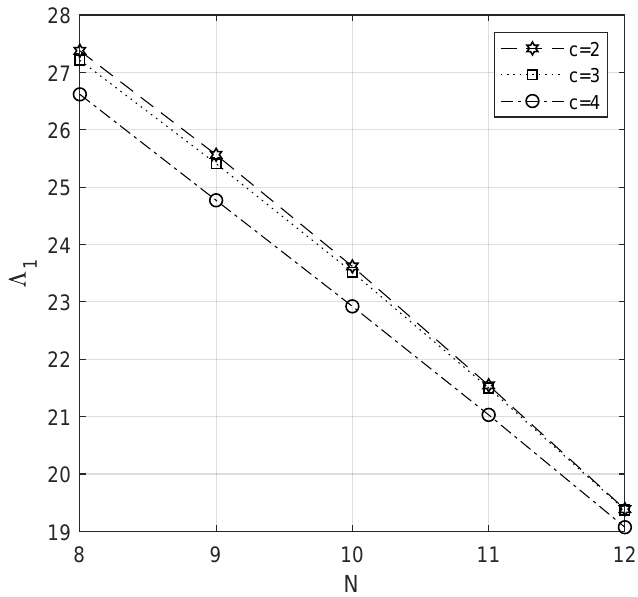
Figure 13. The impact of mean inventory level when N vs. c .